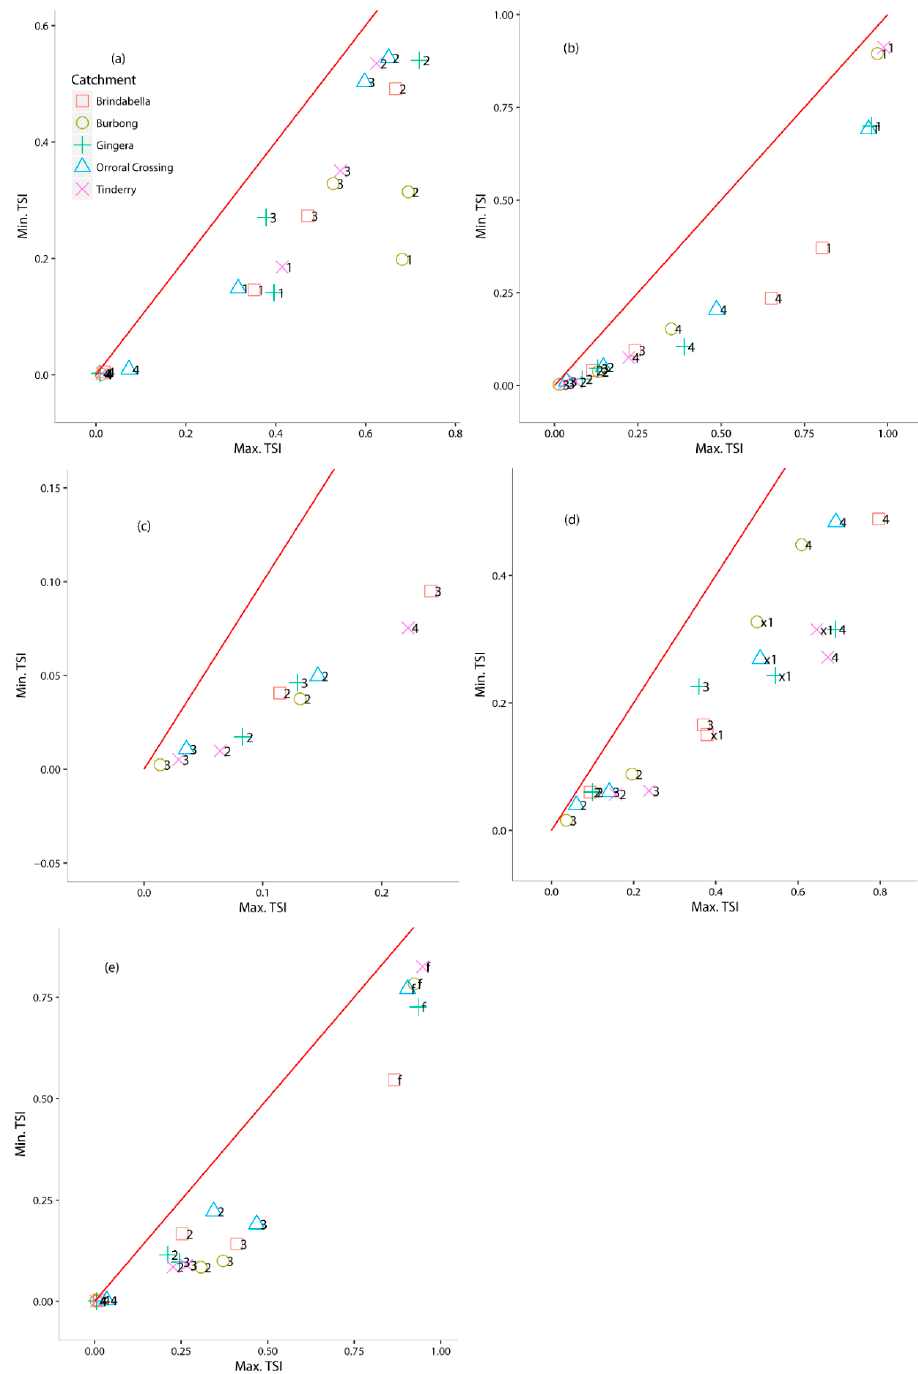
Figure 7. Sensitivity of the parameters of the four rainfall–runoff models for the five catchments to the NSElog* target function: ( a ) result of the GR4J model, ( b ) IHACRES model, ( c ) zoom of ( b ), ( d ) GR_IH model ( x 1 is the parameter of the GR4J model), and ( e ) IH_GR model ( f is the parameter of the IHACRES model). The one-to-one line is shown in